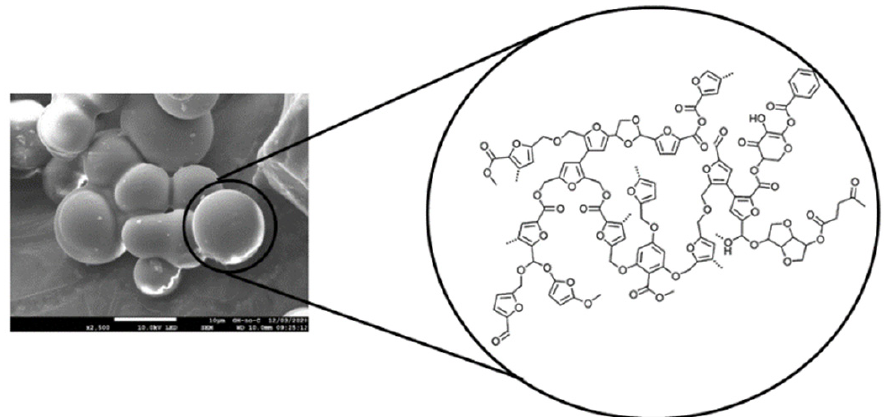
Figure 1. The morphology and molecular structure of humins obtained from C6 sugars (Adapted with permission from Ref [19,21], Elsevier, 2022),